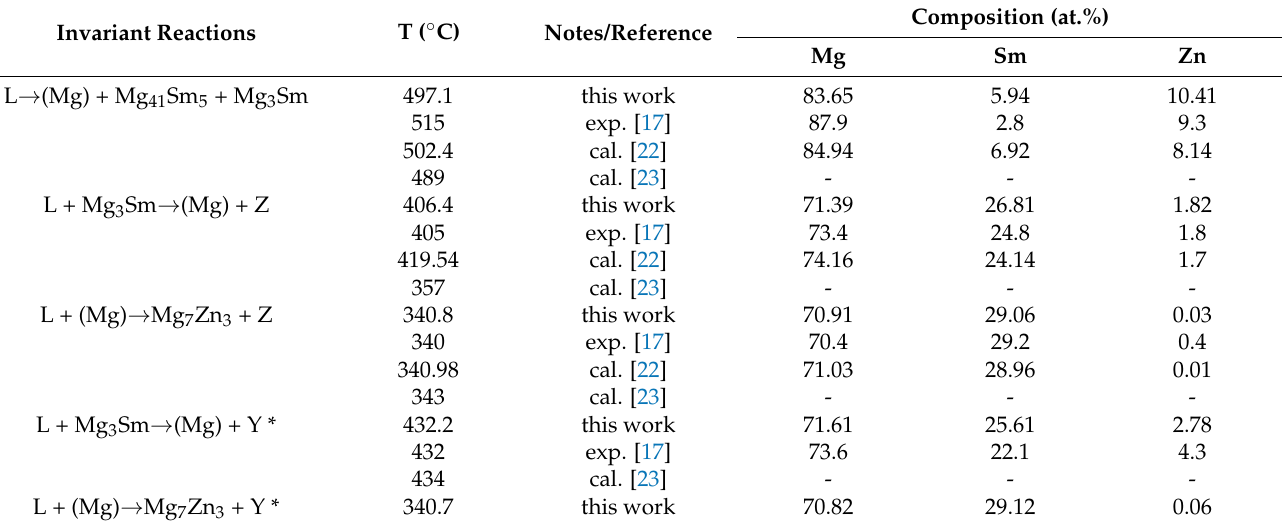
Figure 11. The calculated liquidus projection ( a ) without Y phase and ( b ) with Y phase. Solidification paths of the as-cast alloys ( c ) #3 and ( d ) #7. Table 4. The invariant reactions in the Mg-rich corner of the Mg-Zn-Sm system.